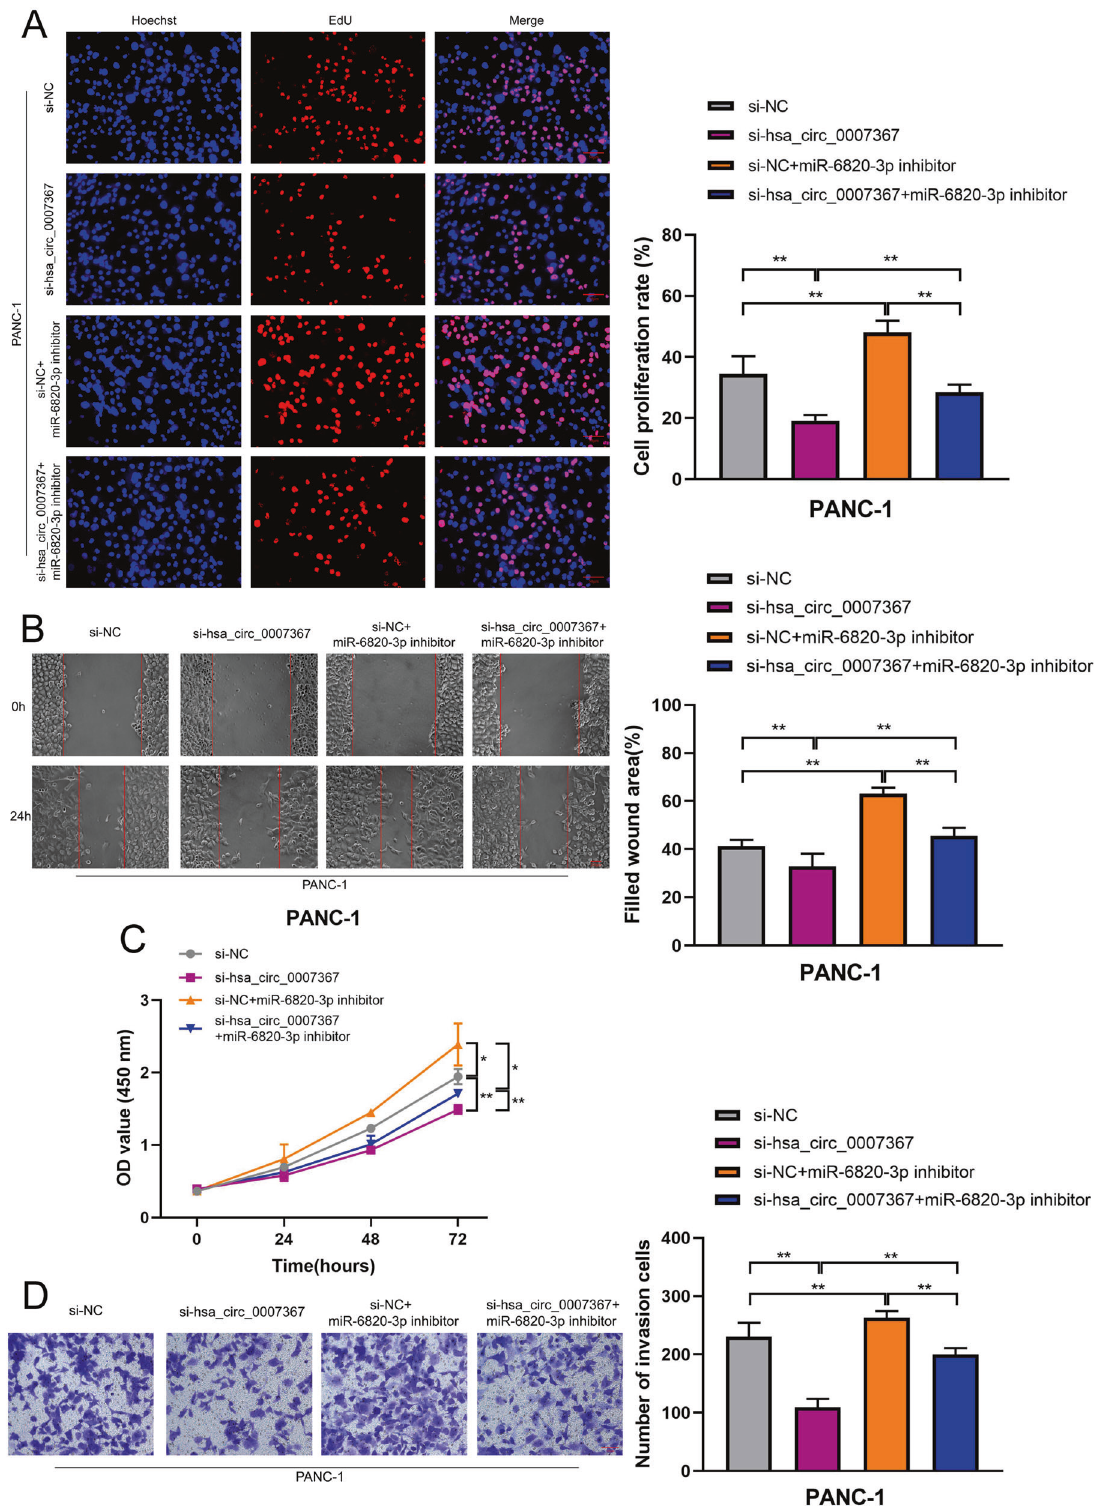
Fig. 6 MiR-6820-3p inhibitor reverses the effects of si-hsa_circ_0007367 on proliferation, migration, and invasion in PDAC cells. A – D EdU ( A ), wound healing ( B ), CCK-8 ( C ), and transwell invasion D assays demonstrated that co-transfection with the miR-6820-3p inhibitor could reverse the proliferation, migration and invasion ability of PANC-1 cells after treated with si-hsa_circ_0007367. All data are shown as the mean ± SD of at least three independent experiments. * p < 0.05, ** p < 0.01.